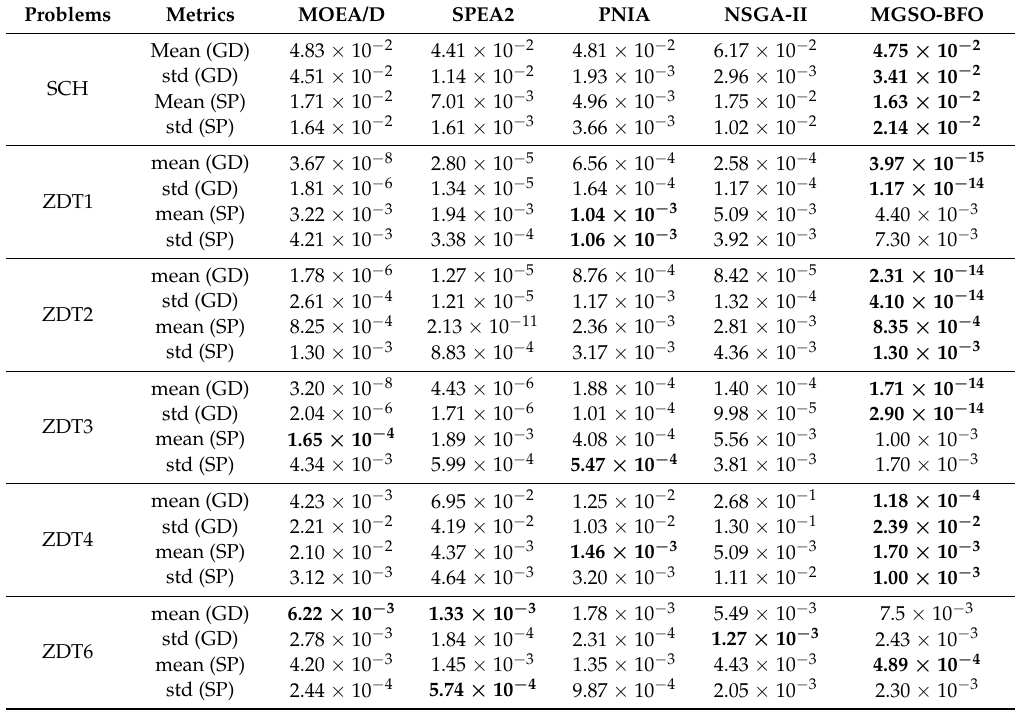
Table A1. Comparison results of GD and SP values of four different algorithms.